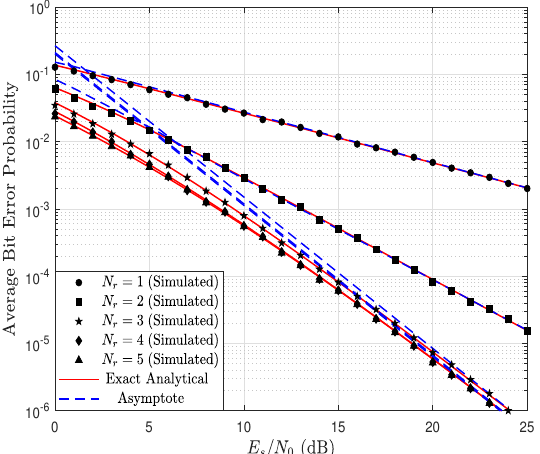
Figure 7. ABEP as a function of E s / N 0 , parameterized by N r considering N d = 5, k r = 1.5, k d = 0.9, λ r = 1.4, λ d = 1 and a = 1.